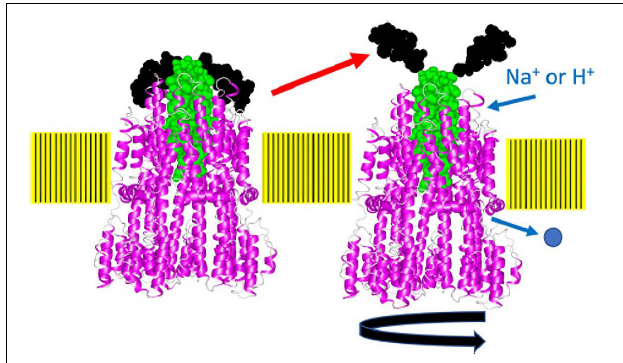
FIGURE 7 | A model of how the plug may block stator rotation and stator activation. When the cytoplasmic region of MotA or PomA interacts with FliG, the plug region of PomB or MotB, which seems to function as a spanner or stopper, is released from the periplasmic loop regions (the putative right structure). The pentamer of the A subunit rotates around the B subunit driven by ion flow. The structure of the flagellar stator (PDB: 6YKM) which is stopped state (the left structure), is shown by a ribbon diagram, with MotA in magenta and MotB in green. The spanner region is shown in black in a space-filling model. This figure is taken from our previous paper (Homma et al.,